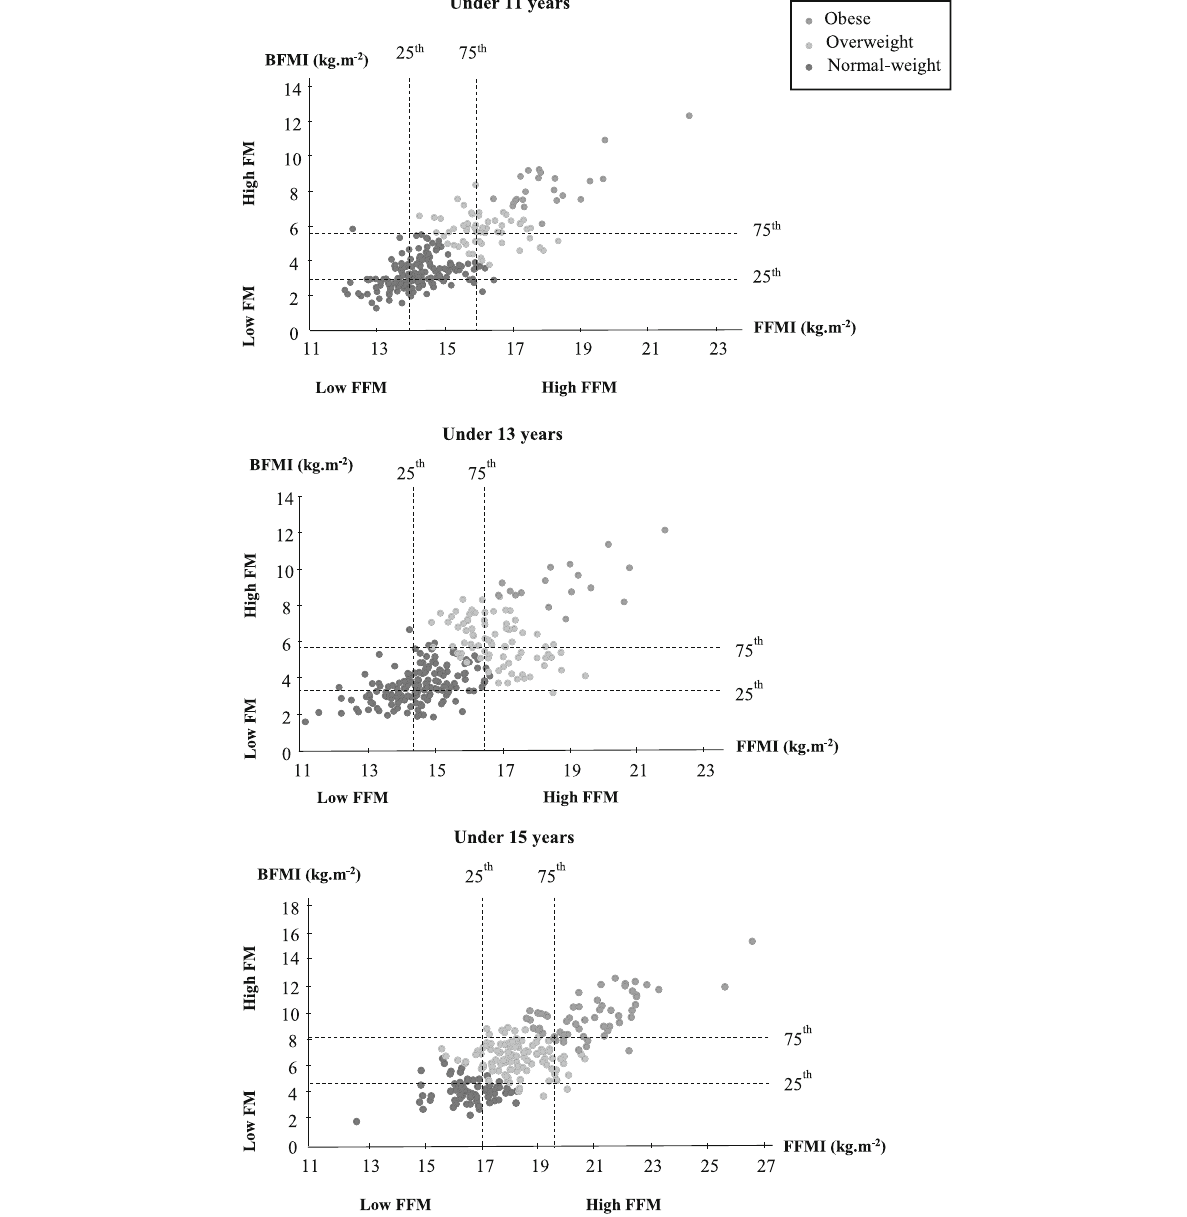
Fig. 2 Levels of fat-free mass index (FFMI) versus body fat mass index (BFMI) according to the 25 – 75th percentile distribution among young male rugby players by age category. Notes: FM, fat mass; FFM, fat-free mass. Low FM < 25th BFMI percentile; high FM > 75th BFMI percentile; low FFM < 25th FFMI percentile; high FFM > 75th FFMI